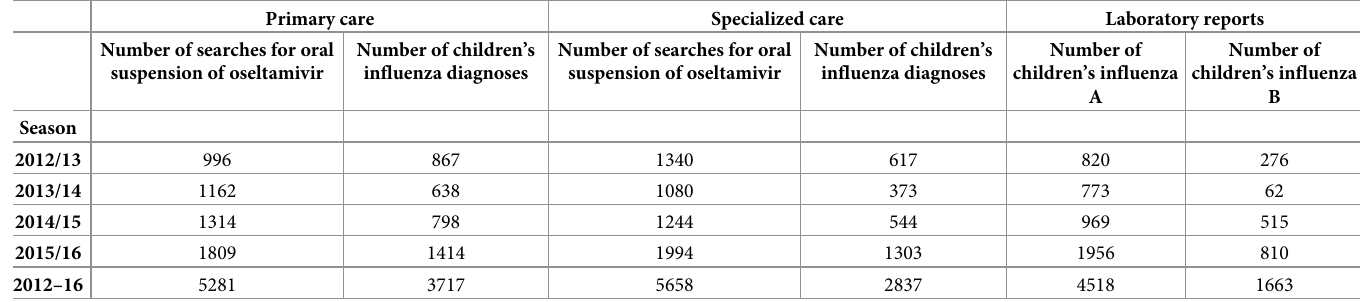
Table 1. Total number of searches for oral suspension of oseltamivir, children’s influenza diagnoses in primary and specialized care, and laboratory reports of chil- dren’s influenza A and B across Finland 2012–2016 by